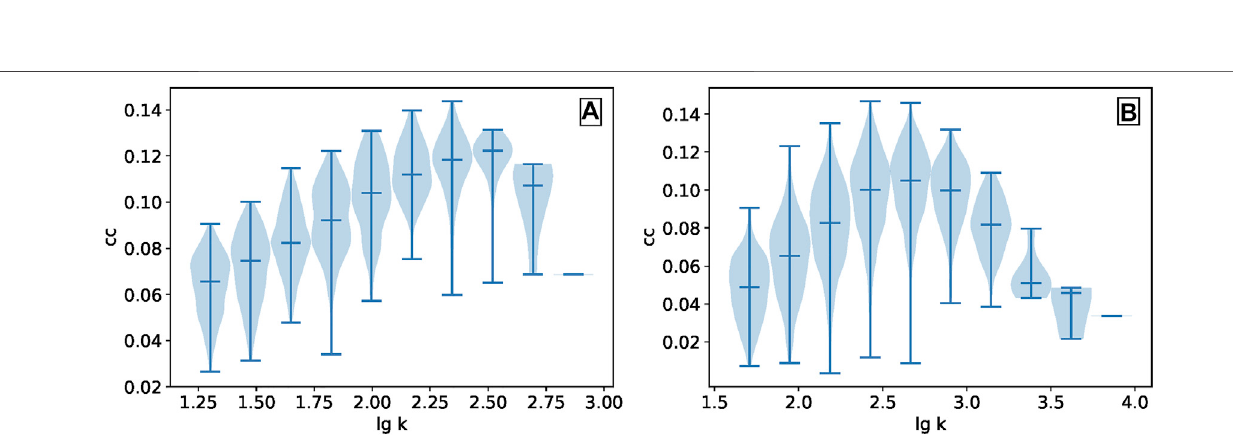
FIGURE 4 | The AUC, R c and RS values of different methods with different ρ in the random spammer case for (A-C) MovieLens and (D-F) Net fl ix datasets. The parameter ω is 0.05 and 0.01 for MovieLens and Net fl ix, respectively. The results are averaged over 10 independent realizations.